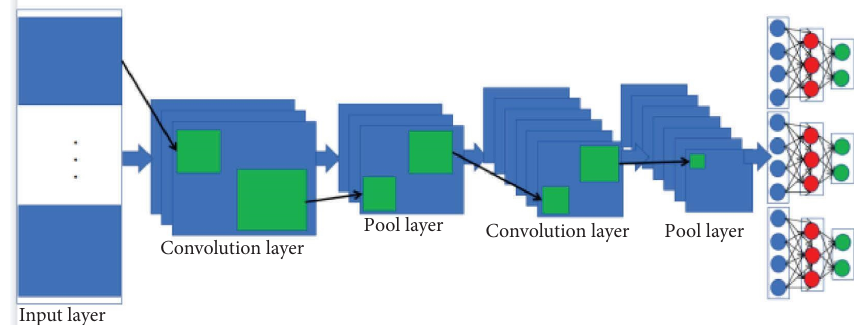
Figure 1: Structure of